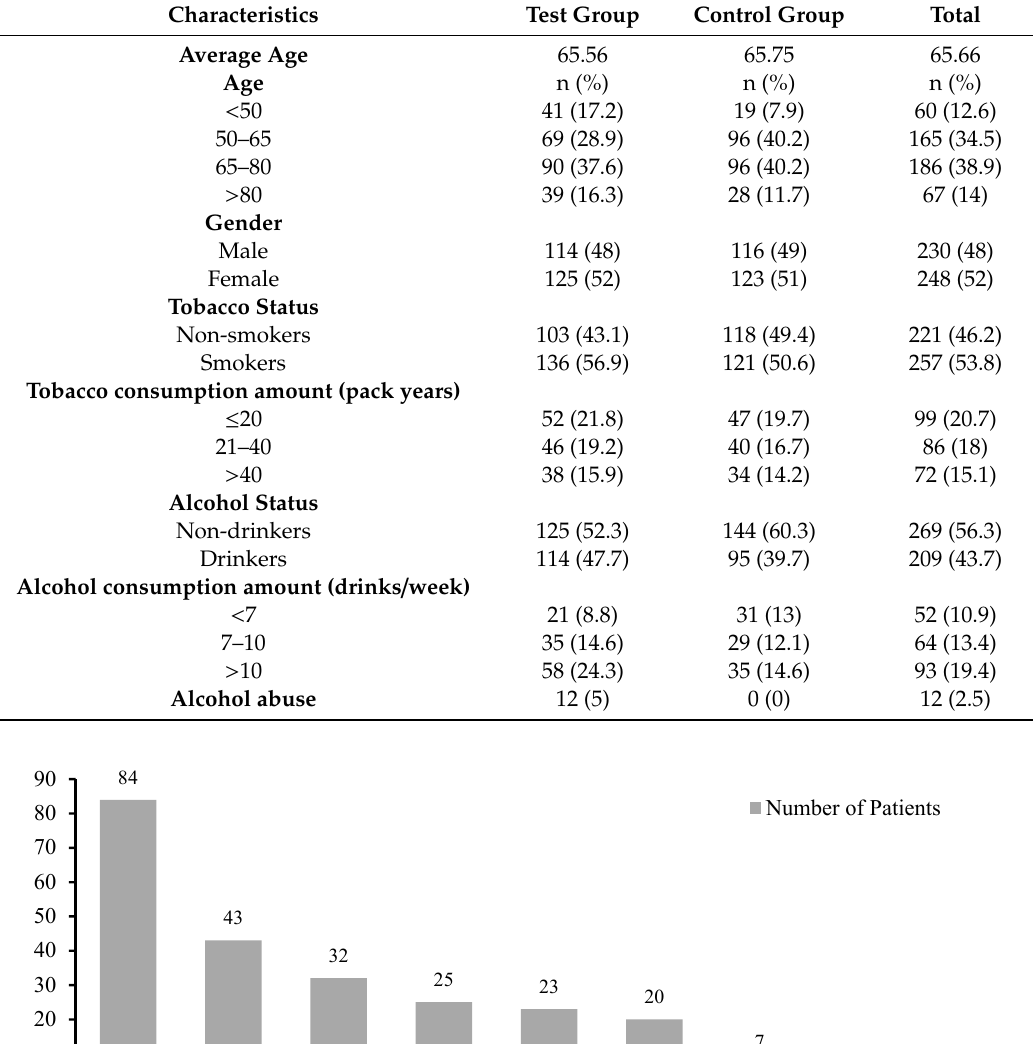
Table 1. Patients’ preview and characteristics.